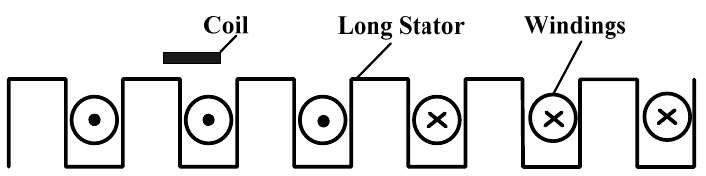
Figure 2. Diagram of the sensor coil and the long